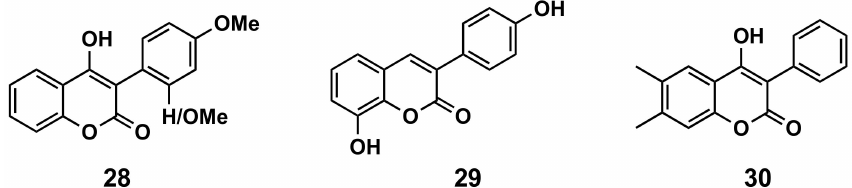
Figure 14. 3-Phenylcoumarins in